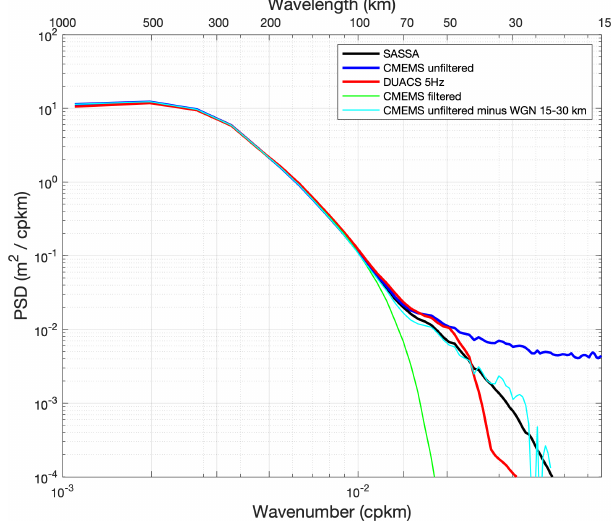
Figure 12. Mean PSD of SARAL SLA along-track measurements: CMEMS unfiltered (blue), SASSA (black), DUACS 5Hz (red), CMEMS filtered (green), and CMEMS unfiltered minus a mean WGN computed over 15–30km wavelength. The PSDs are com- puted as the average of PSDs obtained for all individual data seg- ments covering the year 2017 and the Gulf Stream region (72– 60 ◦ W, 44–32 ◦